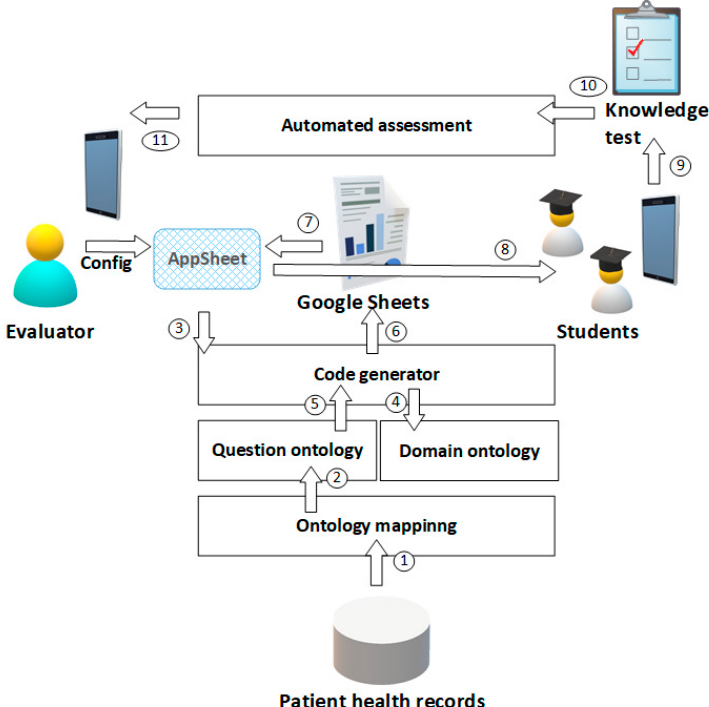
Figure 3. Ontology-driven framework for automated SCT question generation: 1, 2—mapping of patient health records DB to SCT question ontology; 3—question topic and difficulty settings; 4—SPARQL queries; 5—query results; 6—code generation results; 7—rendering mobile app starting